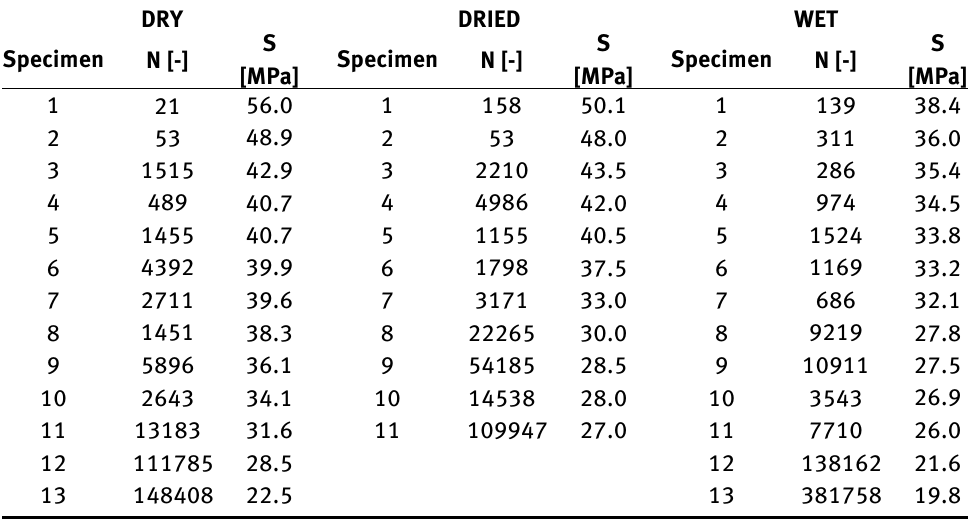
Table 3: Fatigue raw data. S represents maximum stress in MPa. The R ratio was